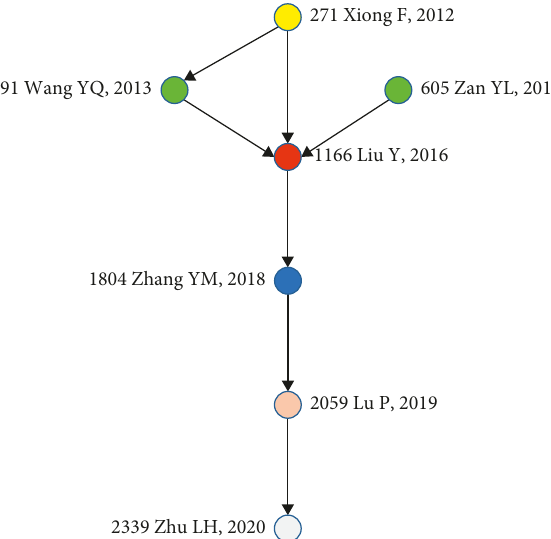
Figure 6: Local forward main path in dynamic complex network